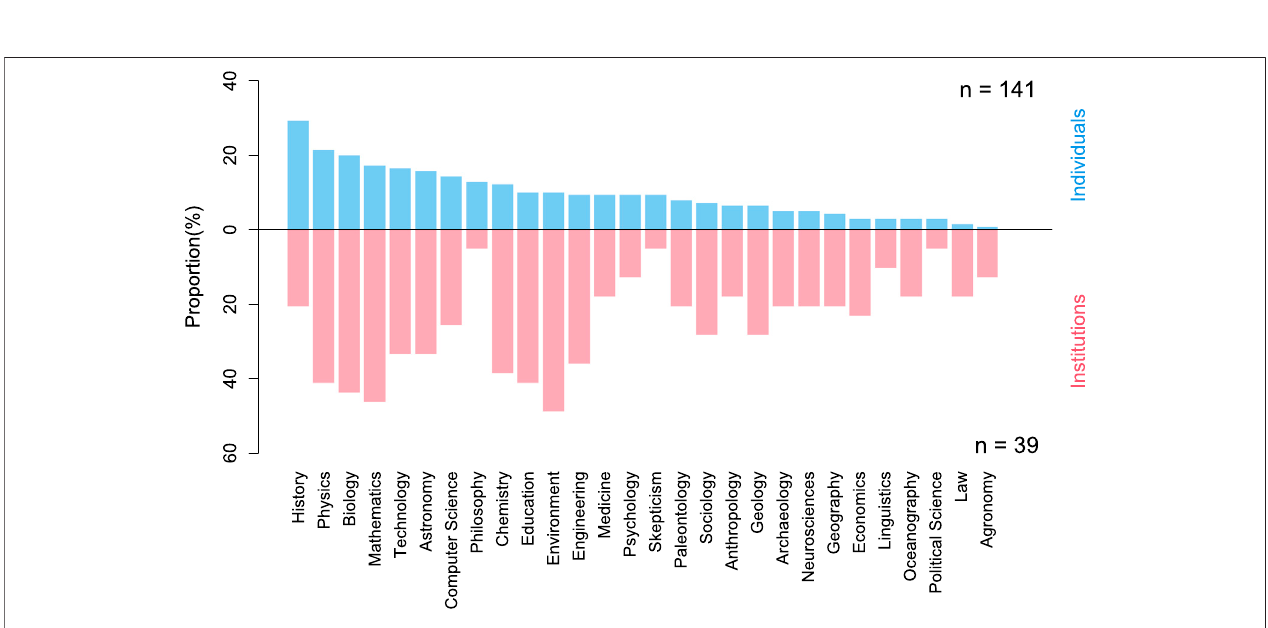
FIGURE 4 | Publication frequency computed from YouTube data (top) and reported in the survey (bottom) .